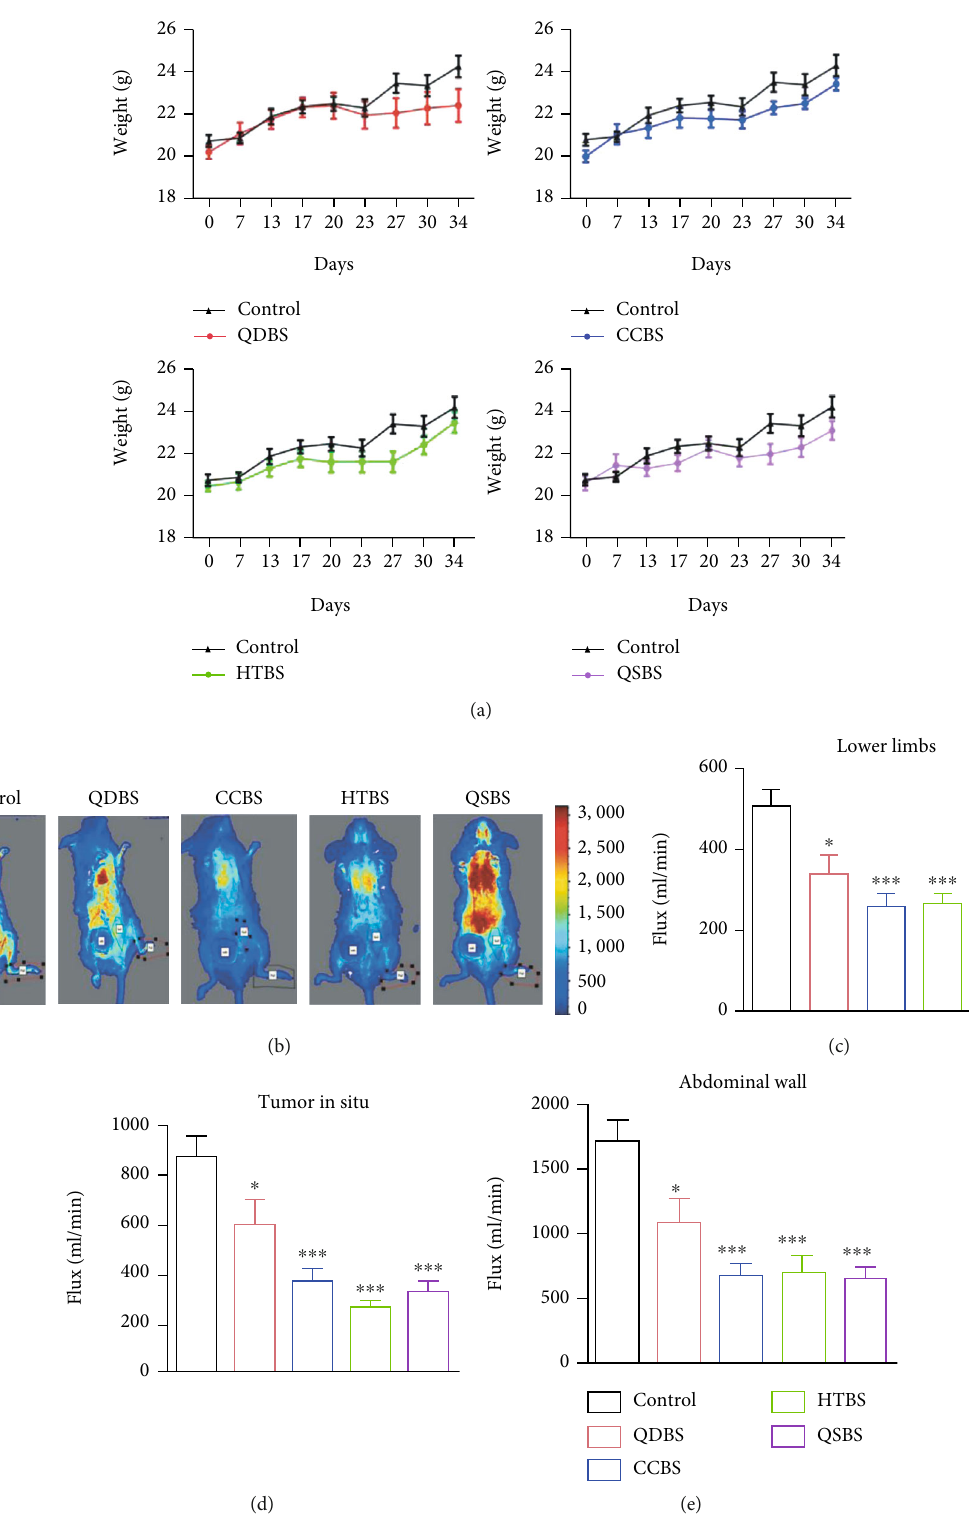
Figure 1: Body weight and microcirculation of mice. (a) Weight of the mice in each group. Tumor cells were injected on day 7 and started growing on day 13. We weighed the mice on days 0, 7, 13, 20, 23, 23, 27, 30, and 34 after moulding. (b) Representative image of microcirculation in mice from each group. (c) Quantitative statistics of microcirculation in the lower limbs. (d) Quantitative statistics of tumor microcirculation. (e) Quantitative statistics of abdominal wall microcirculation. ∗ P < 0 : 05 , ∗∗ P < 0 : 01 , and ∗∗∗ P < 0 : 001 , vs.